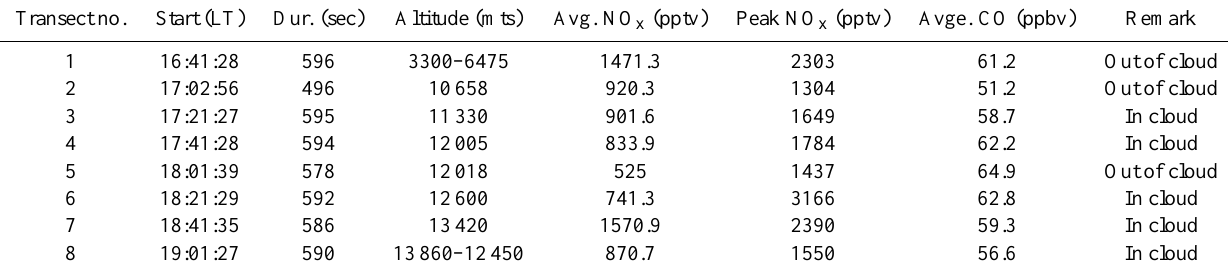
Table 1. Egrett NO x and CO transect parameters as measured by the Egrett on 22 January 2006. Transect